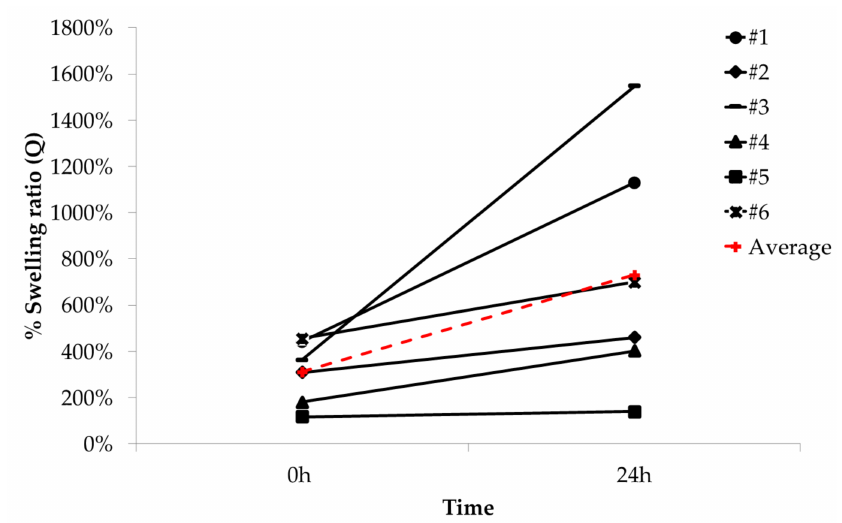
Figure 3. Swelling ratio (%) of each NFC / A sca ff old (N = 6) and average swelling ratio at 0 and 24 h after